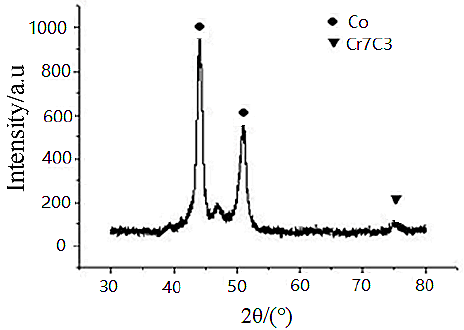
Figure 3. XRD spectrum of bushing surface coating.